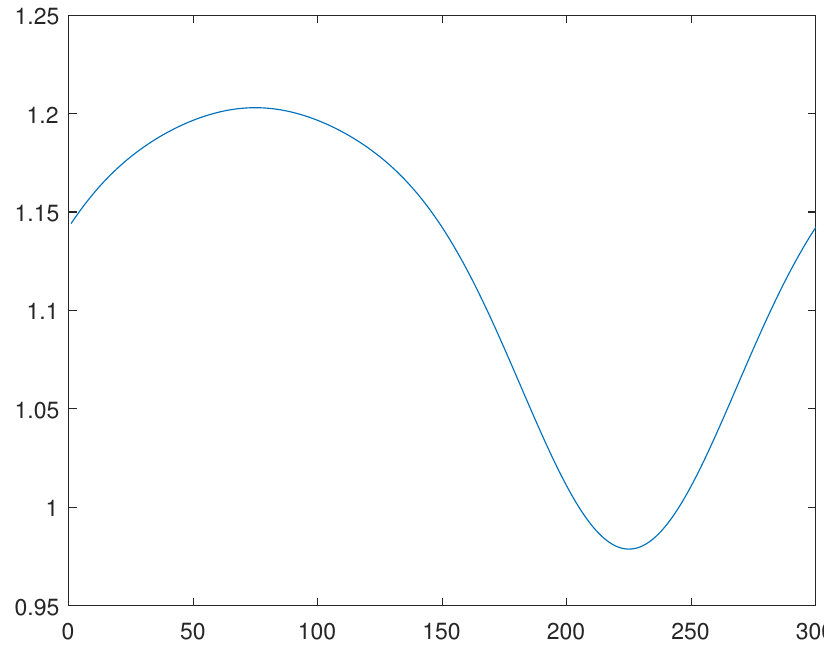
Figure 5. Line 4, solution u 4 ( x ) through Newton’s Method.